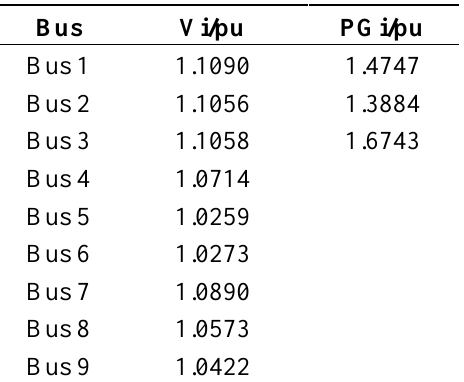
Table 3. Optimal Operating Point (OOP) given by the DOPF (Distributed Optimal Power Flow).